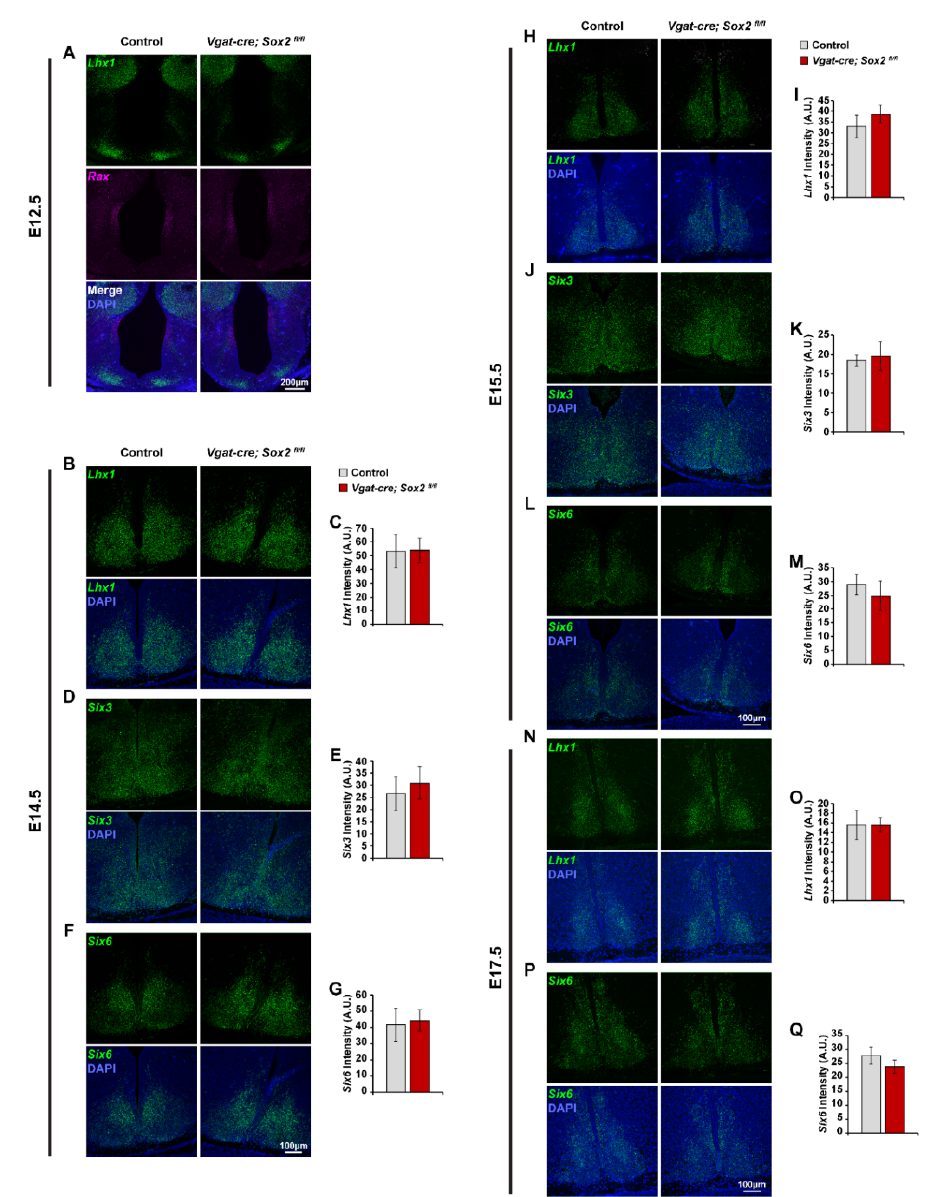
Figure 6. The expression of major SCN-enriched transcription factors is preserved in the embryonic, Sox2 -deficient SCN. ( A ) Representative photomicrographs of Lhx1 (green) and Rax (magenta) expression in the anterior hypothalamus of E12.5 control and Vgat-cre;Sox2 fl/fl mutant embryos. Blue denotes DAPI. ( B , D , F ) Representative photomicrographs of ( B ) Lhx1 , ( D ) Six3 , and ( F ) Six6 expression (green) in the E14.5 SCN of control and Vgat-cre;Sox2 fl/fl mutant embryos. Blue denotes DAPI. ( C , E , G ) The expression of ( C ) Lhx1 , ( E ) Six3 , and ( G ) Six6 at E14.5 are quantified in arbitrary units of mean grayscale intensity in the whole SCN. ( H , J , L ) Representative photomicrographs of ( H ) Lhx1 , ( J ) Six3 , and ( L ) Six6 expression (green) in the E15.5 SCN of control and Vgat-cre;Sox2 fl/fl mutant embryos. Blue denotes DAPI. ( I , K , M ) The expression of ( I ) Lhx1 , ( K ) Six3 , and ( M ) Six6 at E15.5 are quantified in arbitrary units of mean grayscale intensity in the whole SCN. ( N, P ) Representative photomicrographs of ( N ) Lhx1 and ( P ) Six6 expression (green) in the E17.5 SCN of control and Vgat-cre;Sox2 fl/fl mutant embryos. Blue denotes DAPI. ( O, Q ) The expression of ( O ) Lhx1 and ( Q ) Six6 at E17.5 are quantified in arbitrary units of mean grayscale intensity in the whole SCN. Values represent mean ± SEM. * p < 0.05 versus control mice, two-tailed Student’s t -test. See Table 2 for the number of animals and litters